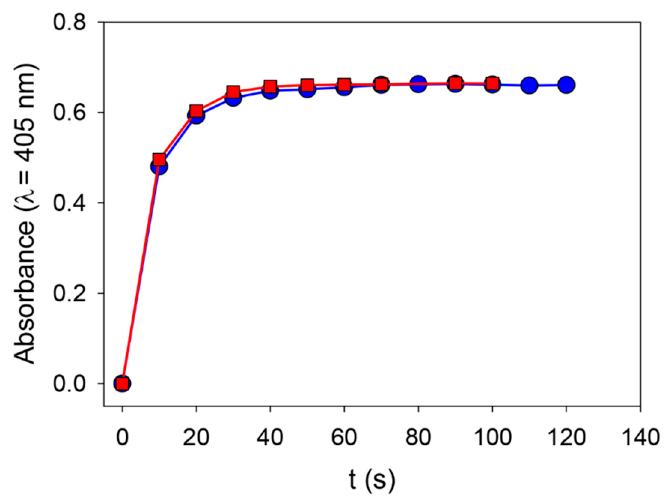
Figure 5. Enzymatic activity of ALP (0.1 mg ∙ mL − 1 ) in the presence of 50 mM Tris buffer ( __ __ ) and in the presence of 50 mM Tris buffer with 20 mM NaIO 4 ( __ __ ).